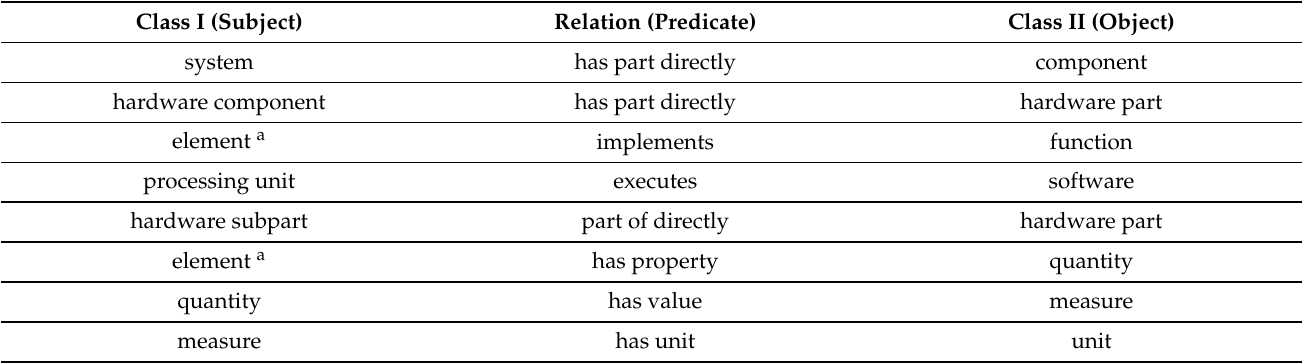
Table 3. Class relations.